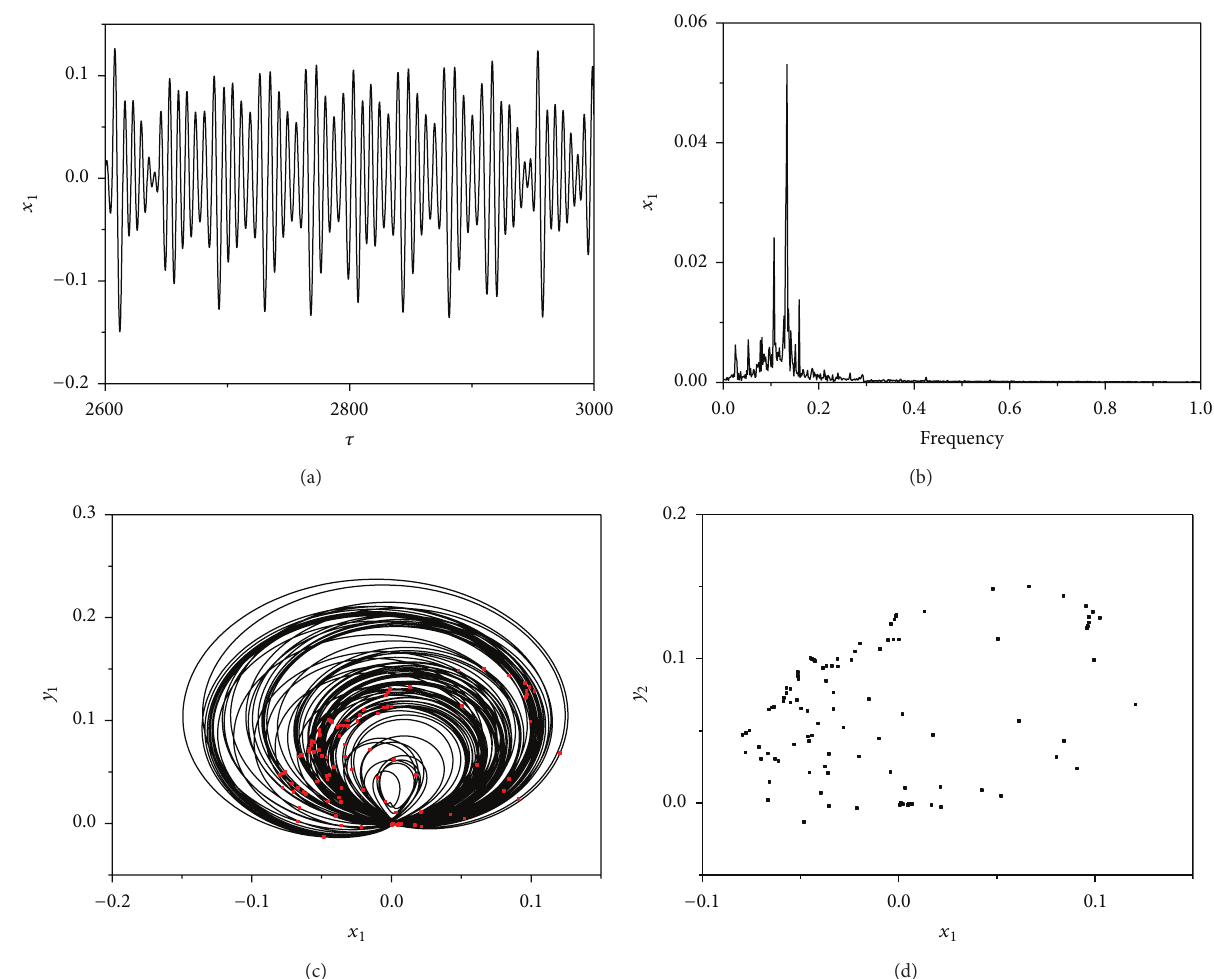
Figure 10: See 𝜔 = 1.30 . (a) Displacement response. (b) Frequency spectrum. (c) Rotor orbit. (d) Poincar´e